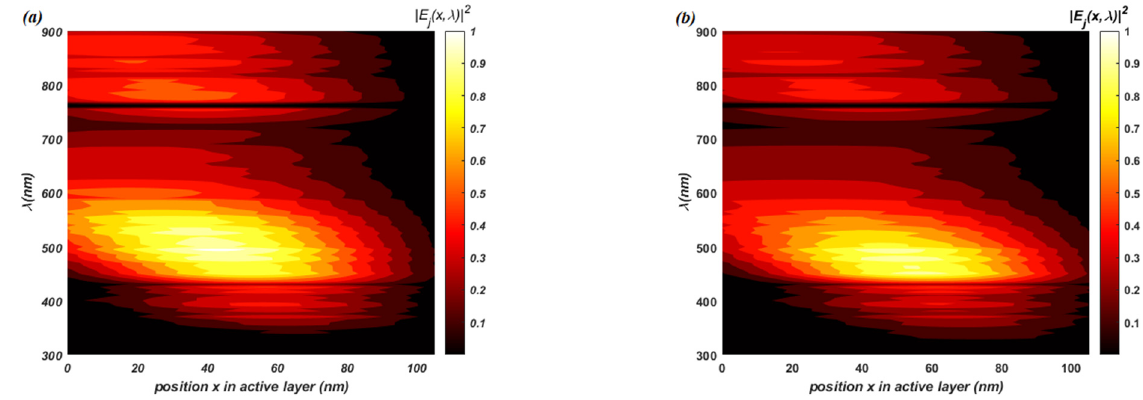
(cid:2870) (cid:12) (cid:12) 2 as a function of x and 𝜆 in ( a ) in- (cid:12) (cid:12) ( x ) as a function of x and λ in ( a ) inverted (cid:12) E j (cid:12)